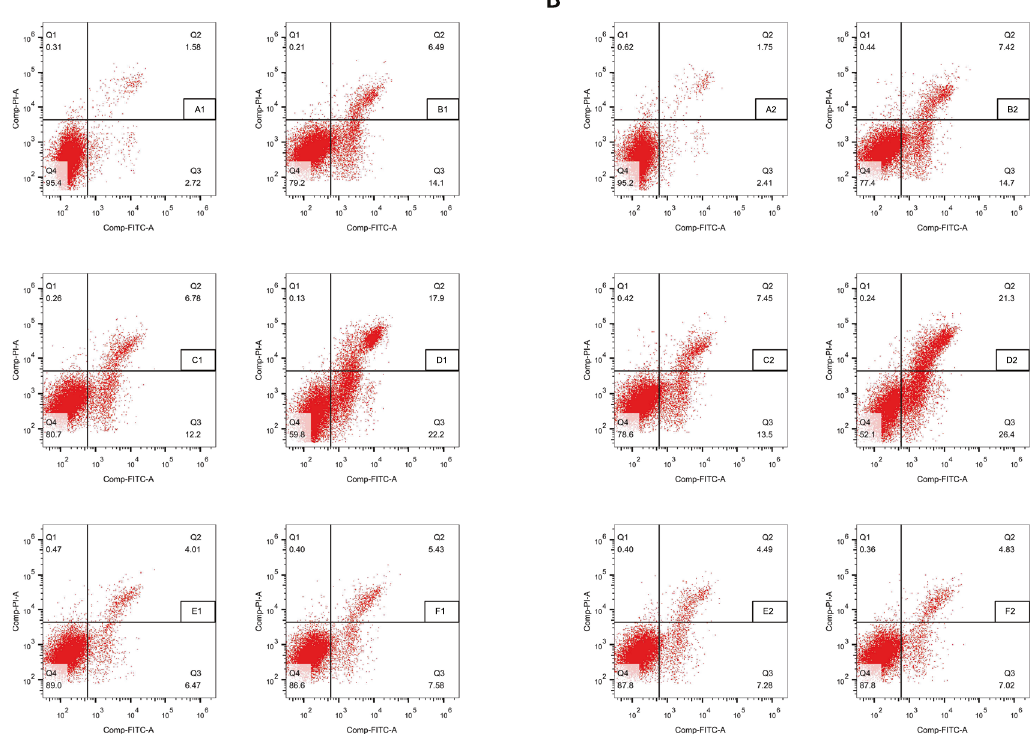
Fig. 3 AnnexinV-FITC fl ow cytometry to detect the rate of apoptosis in the prefrontal cortex and hippocampal neurons derived from listed subgroups in Table 1. The rate of apoptosis is marked in the right upper quadrant. A Flow cytometry of prefrontal cortex neurons. B Flow cytometry of hippocampal